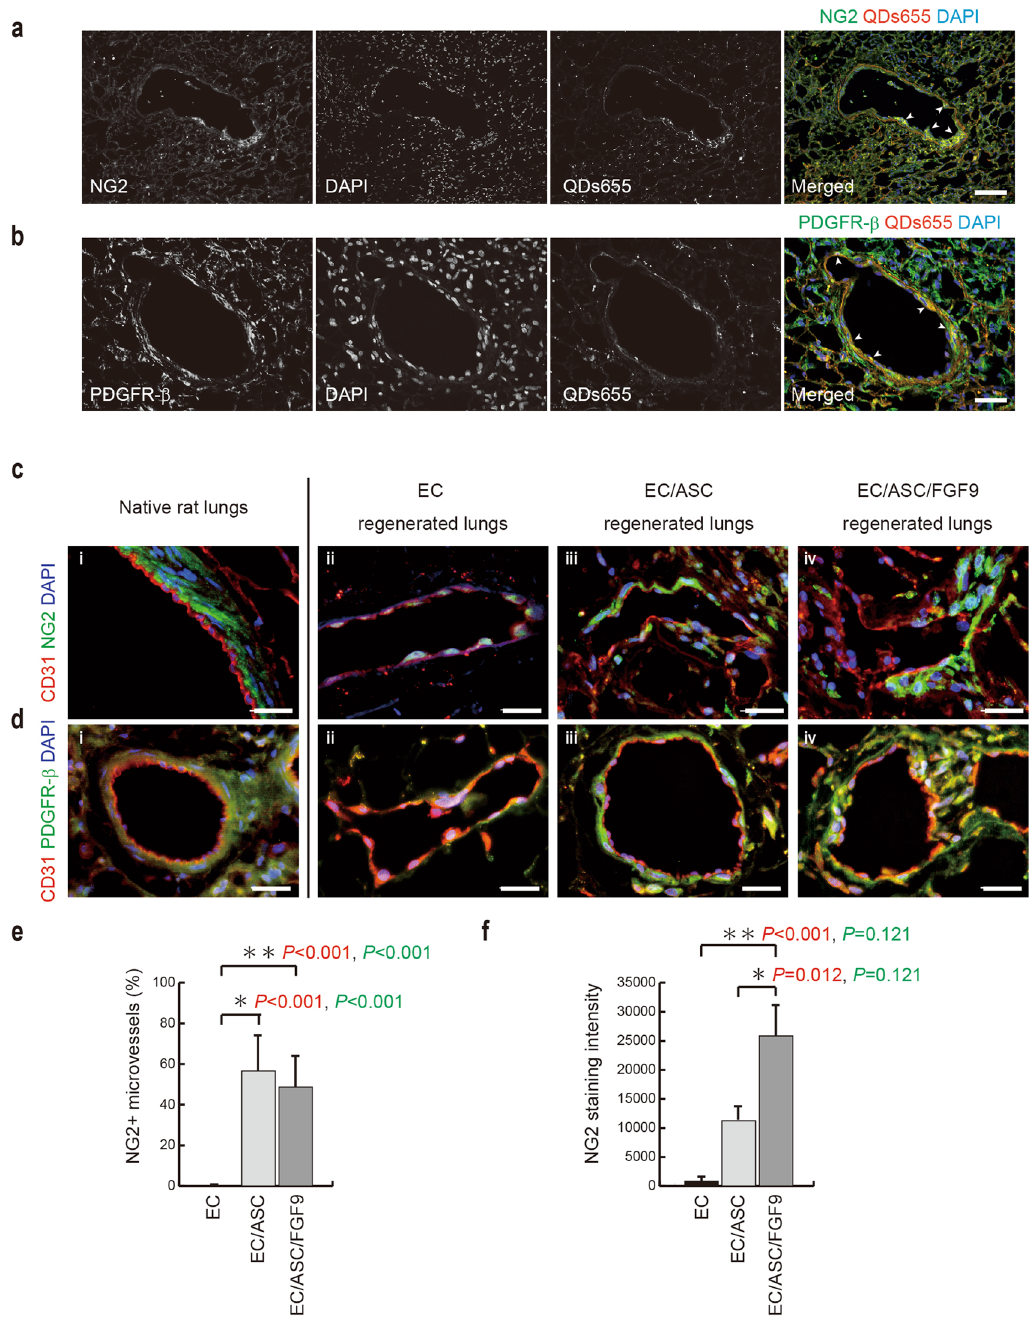
Figure 5. ASC differentiation into pericytes, supported by FGF9, stabilized pulmonary vessels in the regenerated lung. ( a,b ) Corresponding immunofluorescence micrographs of thin sections from EC–ASC- regenerated lungs (day 8 of culture) showing expression of NG2 ( a , green) and PDGFR- β ( b , green) in quantum dots 655 (QDs655)-labeled (red) ASCs. Nuclear DAPI (blue). QDs655-labeled ASCs were clearly localized to the vascular wall and expressed pericytic markers. ( c,d ) Immunofluorescence micrographs of thin sections from native (i) and regenerated lungs (ii–iv, day 8 of culture) showing expression of CD31 (red) with PDGFR- β ( c , green) or CD31 (red) with NG2 ( d , green) around the pulmonary vasculature. Note the perivascular areas of NG2- or PDGFR- β -positive cells are thicker in the EC–ASC–FGF9 group. Nuclear DAPI (blue). Scale bars: 100 μ m ( a ) and 50 μ m ( b–d ). ( e ) Bar graph showing the rate of NG2 + pulmonary vessel formation relative to total pulmonary vessels within the regenerated lung parenchyma. Comparison of all groups; P < 0.001 (ANOVA); P < 0.001 (Kruskal-Wallis test). ( f ) Bar graph showing NG2 staining intensity within the regenerated lung parenchyma. Comparison of all groups; P < 0.001 (ANOVA); P = 0.027 (Kruskal-Wallis test). Comparison of two groups in panels ( e ) and ( f ); the p-values of Bonferroni test and Steel-Dwass test are shown in red and green, respectively. All values are means ± SD of three independent